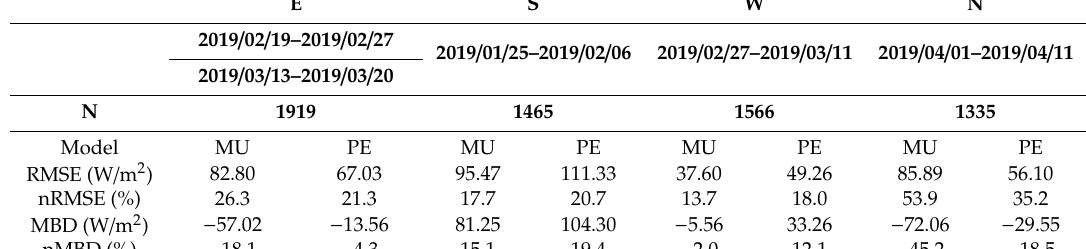
Table 3. Results of the comparison of calculated and measured irradiance data at four di ff erent orientations (E, S, W, N) in the period between 25 January 2019 and 11 April 2019 for the experimental testing ground station in Spain (time intervals every 5 min).